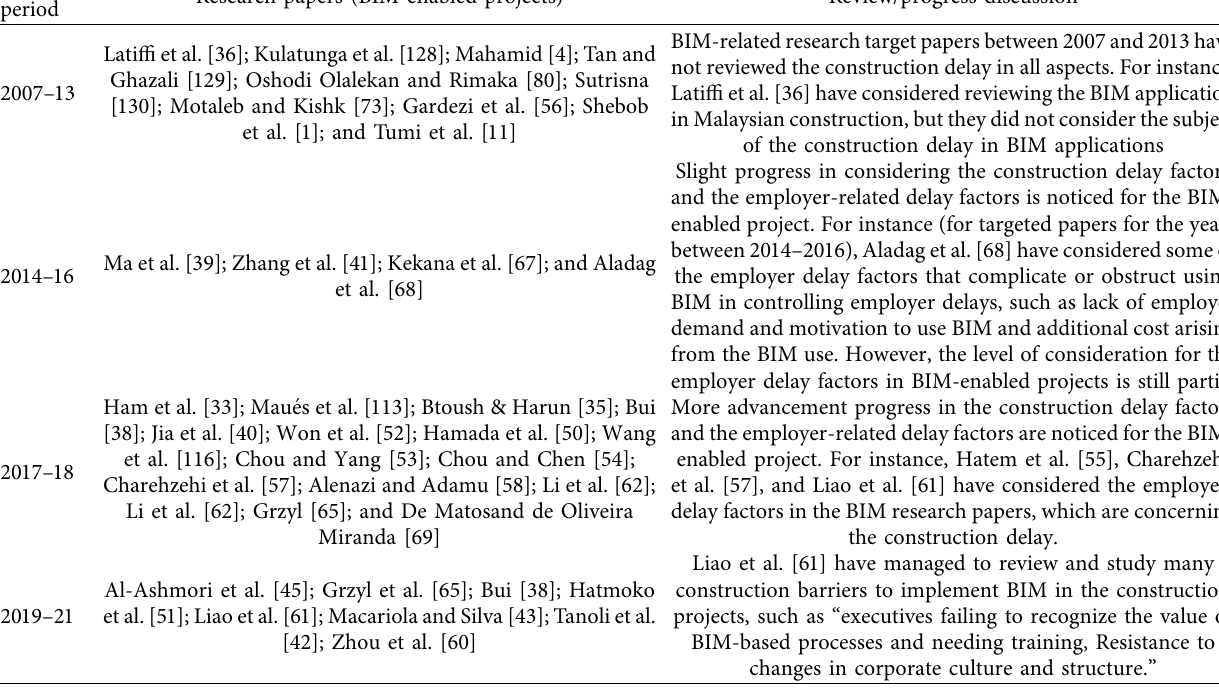
Table 8: A timeline progress review for construction delay aspects addressed in the previous studies for BIM-enabled projects.